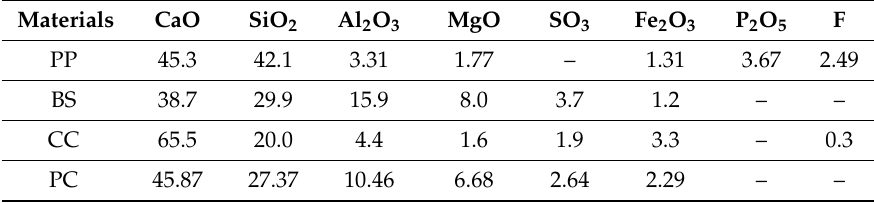
Table 1. Chemical compositions of the main raw materials (mass ratio, %).